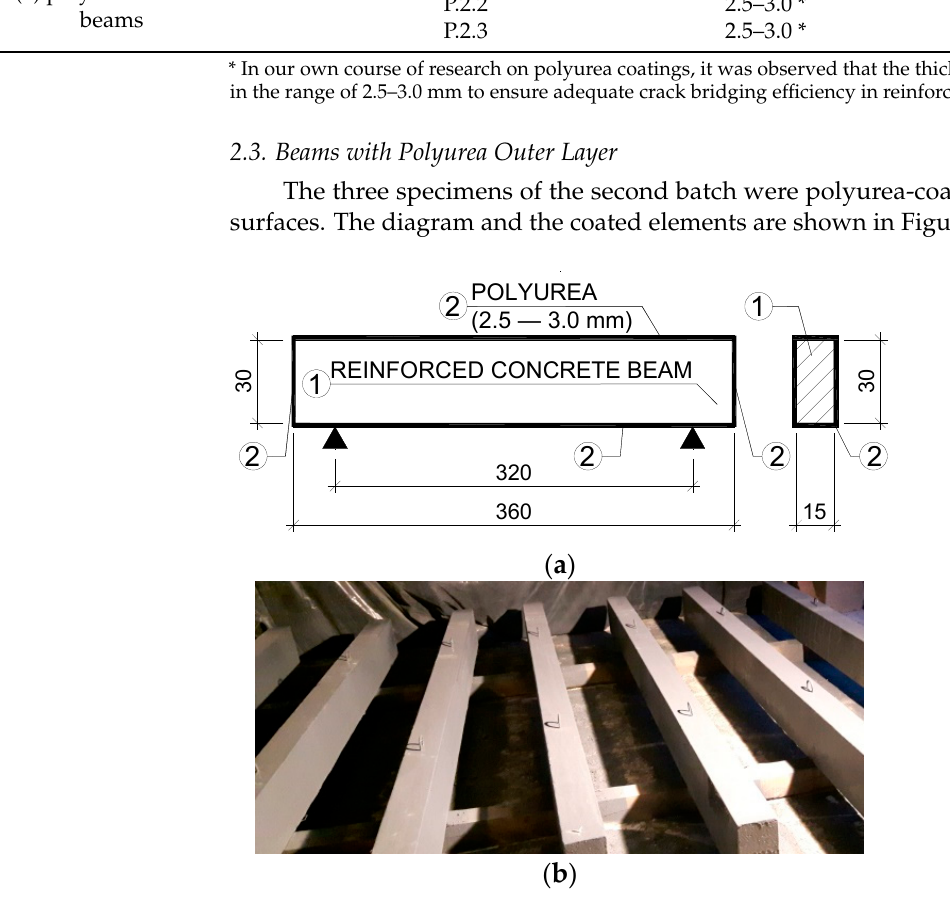
Figure 4. Polyurea-coated elements: ( a ) Coating arrangement (dimensions in cm); ( b ) polyurea-coated elements.